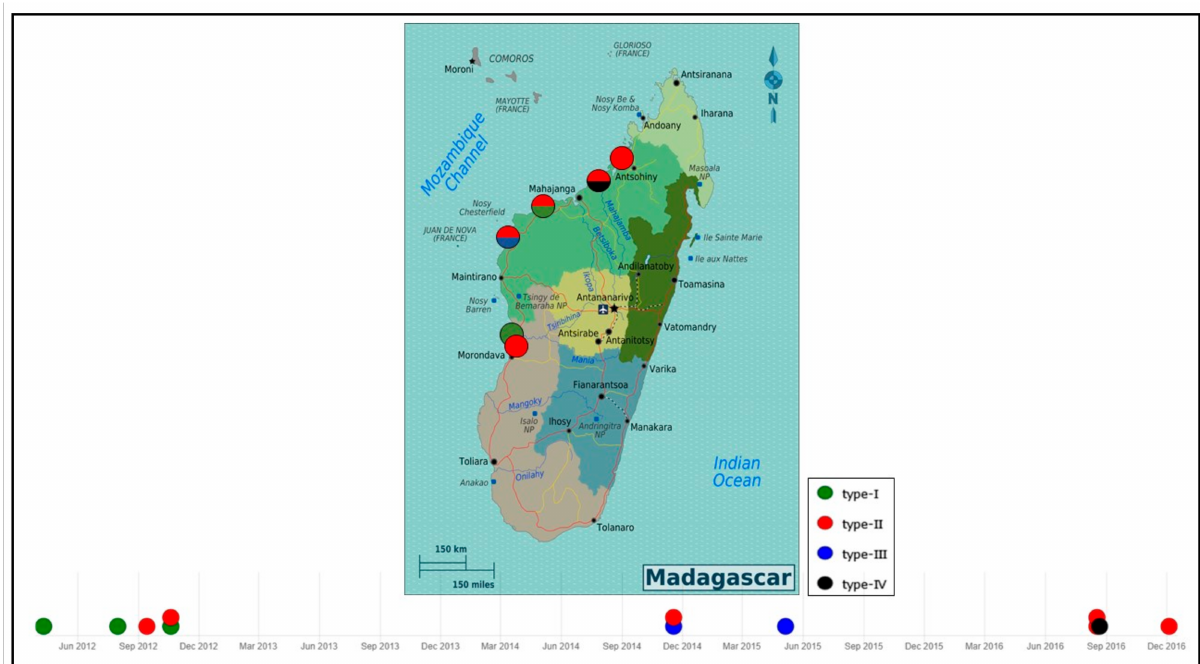
Figure 3. Genotypes of WSSV in the West coast of Madagascar from 2012 to 2016. WSSV genotypes are designed as type-I, type-II, type-III and type-IV (Simulation available at: https://microreact.org/project/eSrC2wJQrXgcxpKZvT4auZ/8432e8 b4, accessed on 18 May